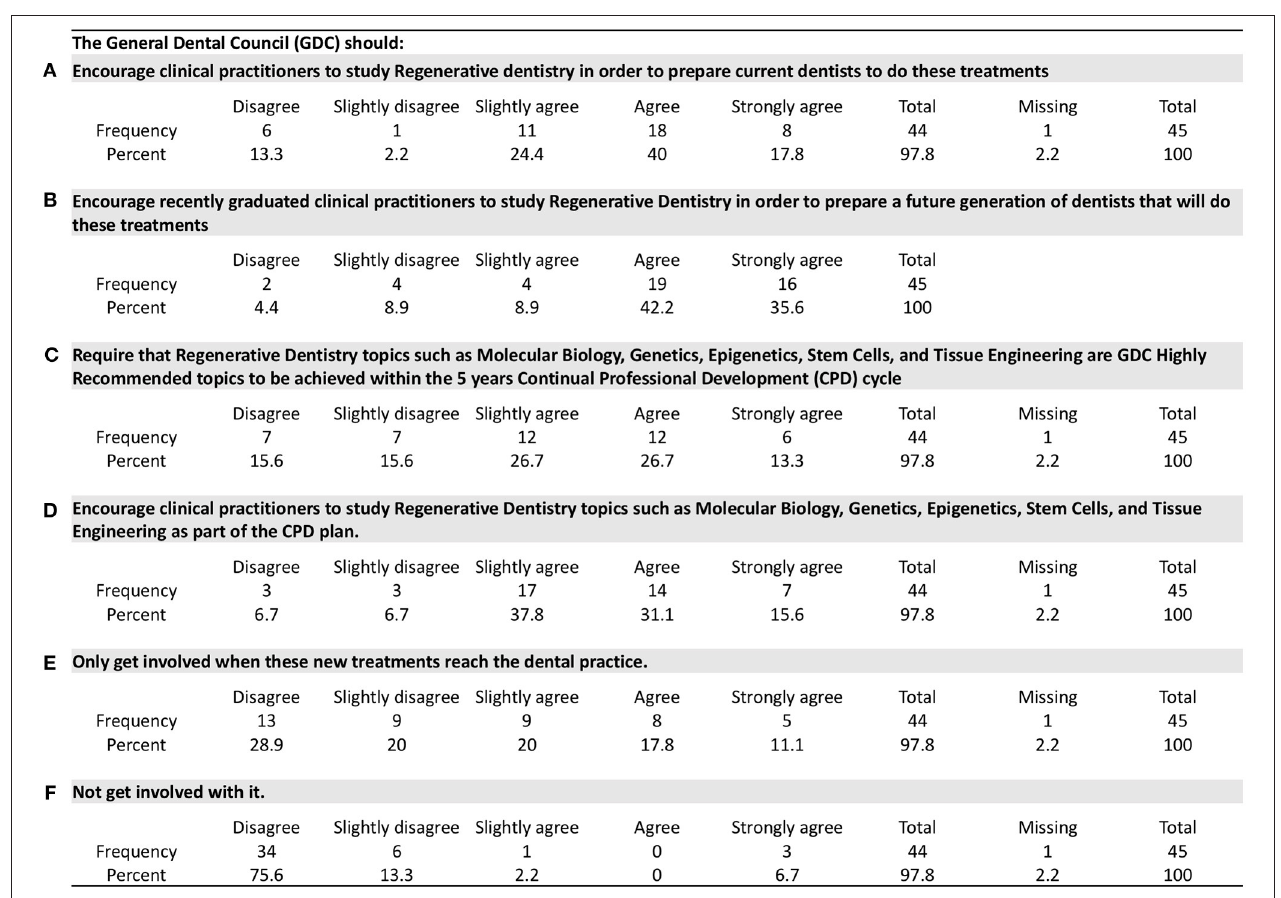
FIGURE 2 | Questions and answers about general dental council (GDC)